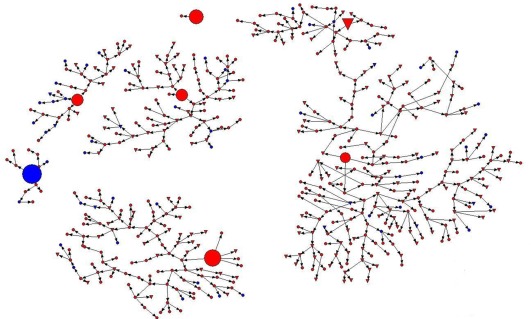
Diagram of respondent driven sampling procedures among MSM in Chongqing City, China: Circles represent non-students while triangles represent students; 7 larger circles or triangles represent the seeds; blue color for HIV-positive and red color for HIV-negative participants.